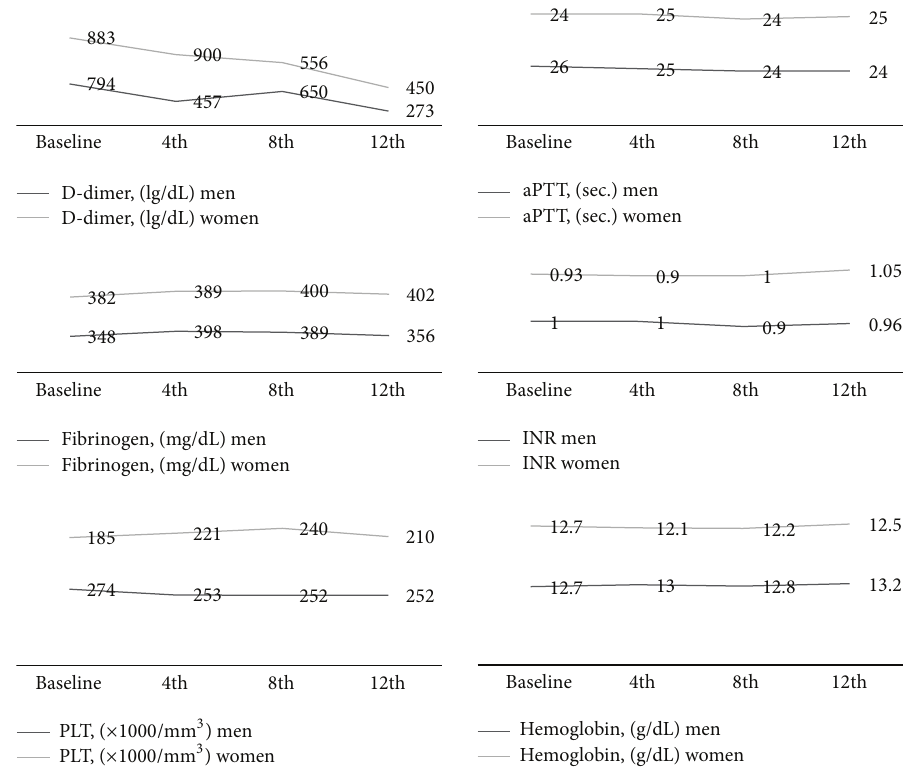
Figure 1: Results of laboratory parameters at baseline and on Day 1 of cycles 4, 8, and